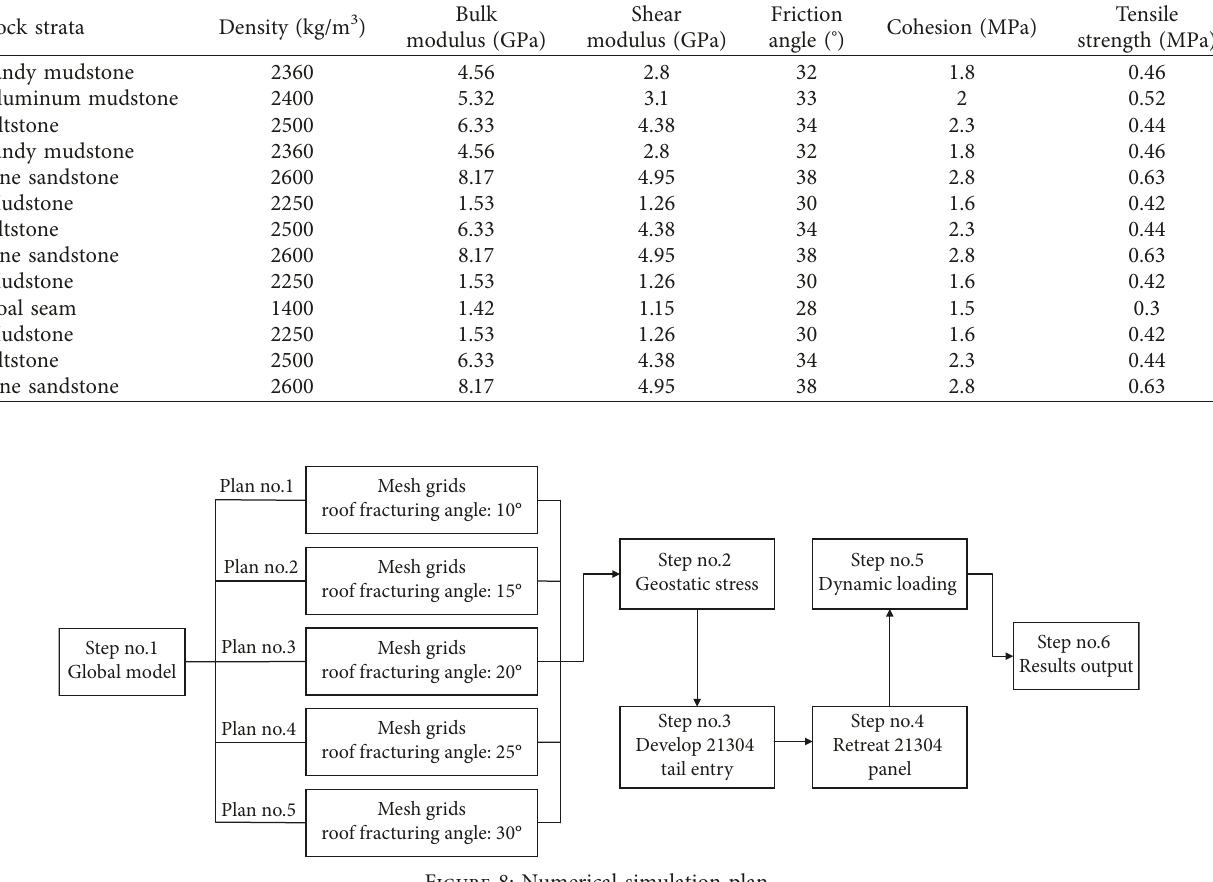
Table 3: Parameters of the rock strata used in the model.